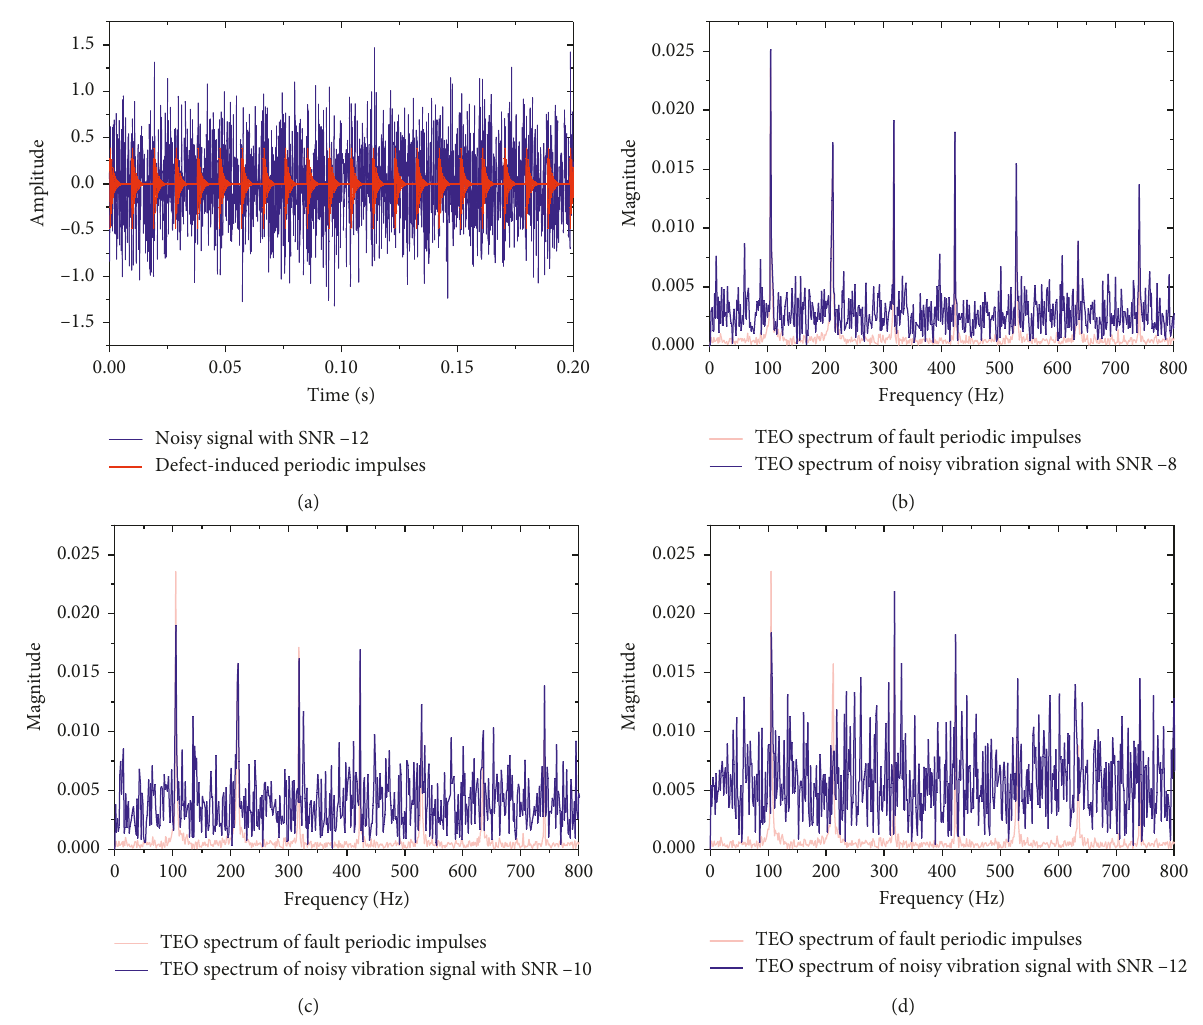
Figure 2: TEO spectrums with different SNRs. The input signal (a) SNR